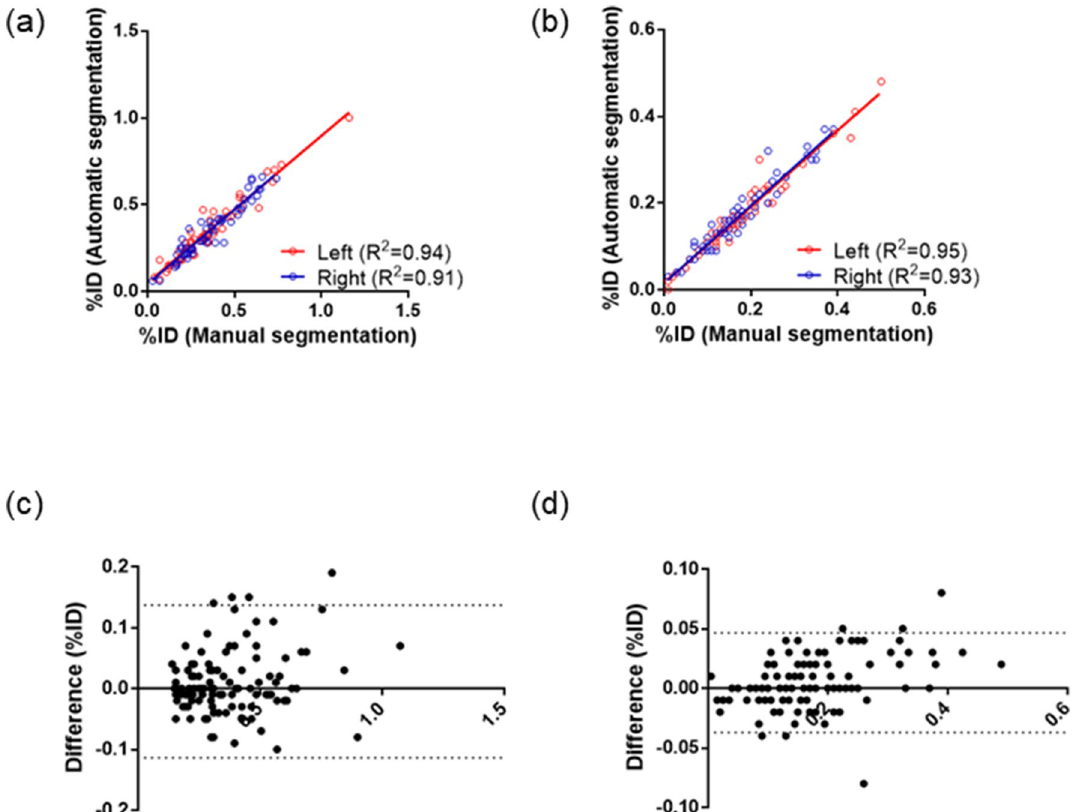
Figure 3. ( a , b ) Scatter plots and ( c , d ) Bland–Altman analyses of %ID measurements, using manual and deep- learning-generated volumes for the ( a , c ) parotid and ( b , d ) submandibular glands in the main